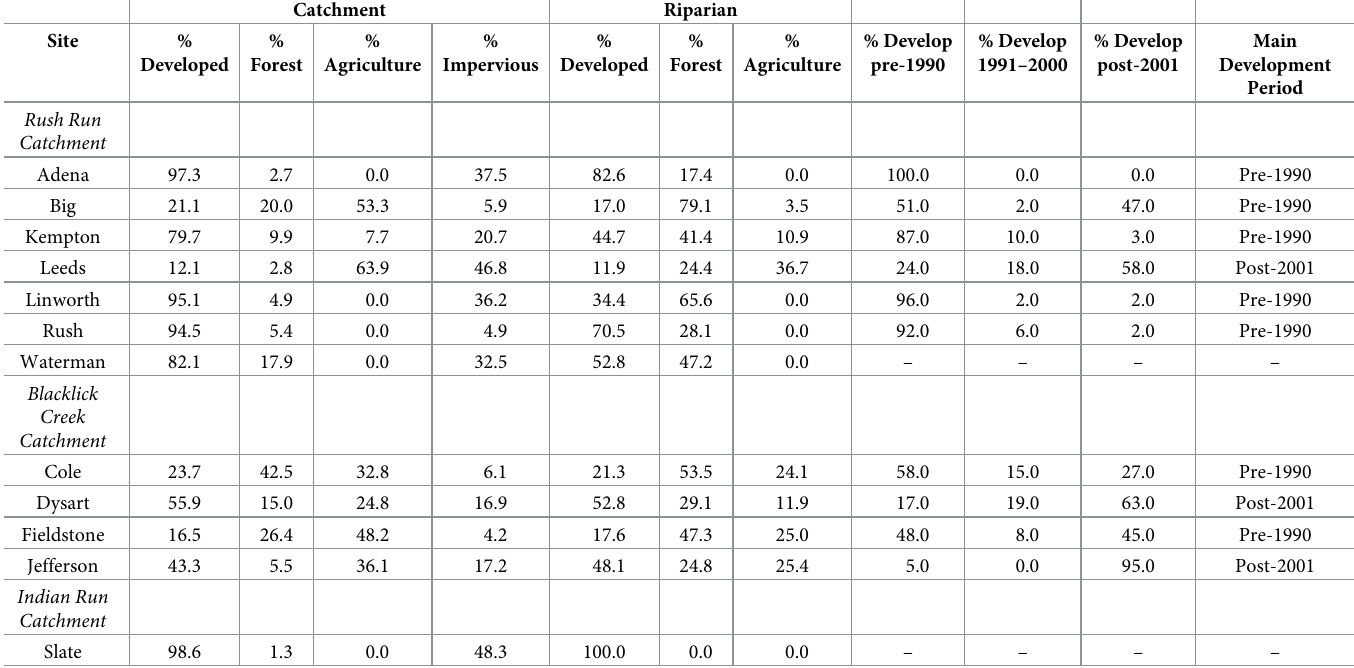
Table 1. Land use/land cover information for all study